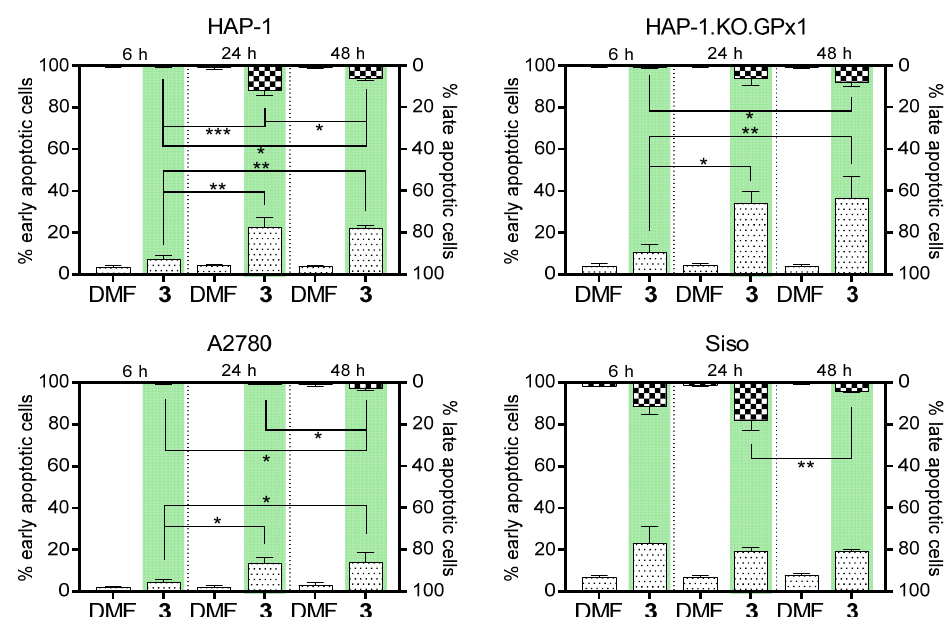
Figure 15. Induction of apoptosis in a time-dependent manner as assessed via annexin V/PI flow cytometric assay after treatment with the representative pentathiepin 3 (IC 90 ) for 6, 24, or 48 h. Negative control cells were incubated with the solvent DMF. The fractions of early apoptotic cells (left y -axis, dotted bars) and late apoptotic cells (right y -axis, checkered bars) are displayed as mean and SD. Resulting gaps correspond to viable cells. The asterisks on brackets denote time-dependent differences. Statistical analysis was performed in Prism 7 by one-way ANOVA and Dunnett’s multiple comparisons post hoc test. n = 3 independent experiments. * p < 0.05, ** p < 0.01, *** p < 0.001.